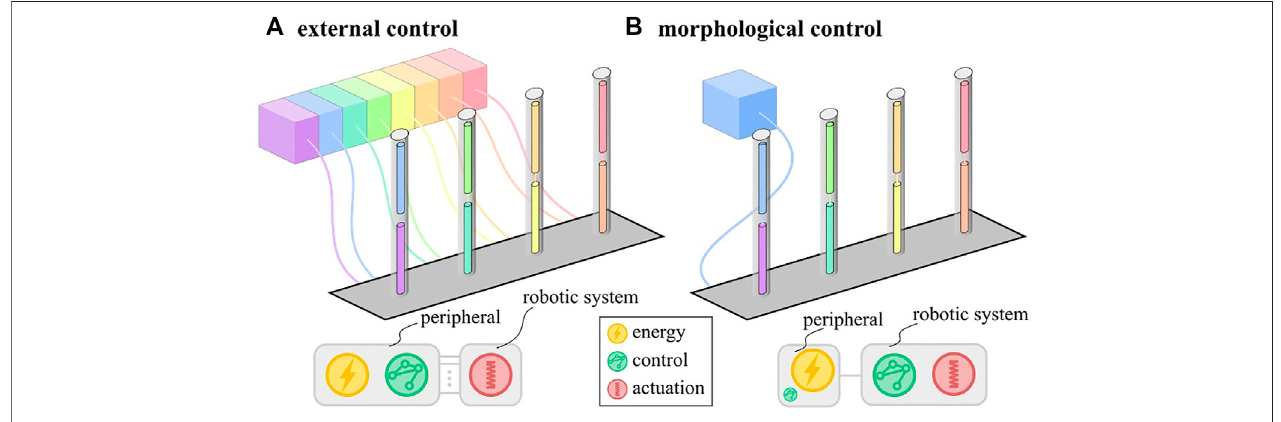
FIGURE 1 | Schematic representation of external (A) and morphological (B) control schemes with distribution of the fundamental functions: energy, control and actuation. In morphological control, the control function is embodied in the robotic system.